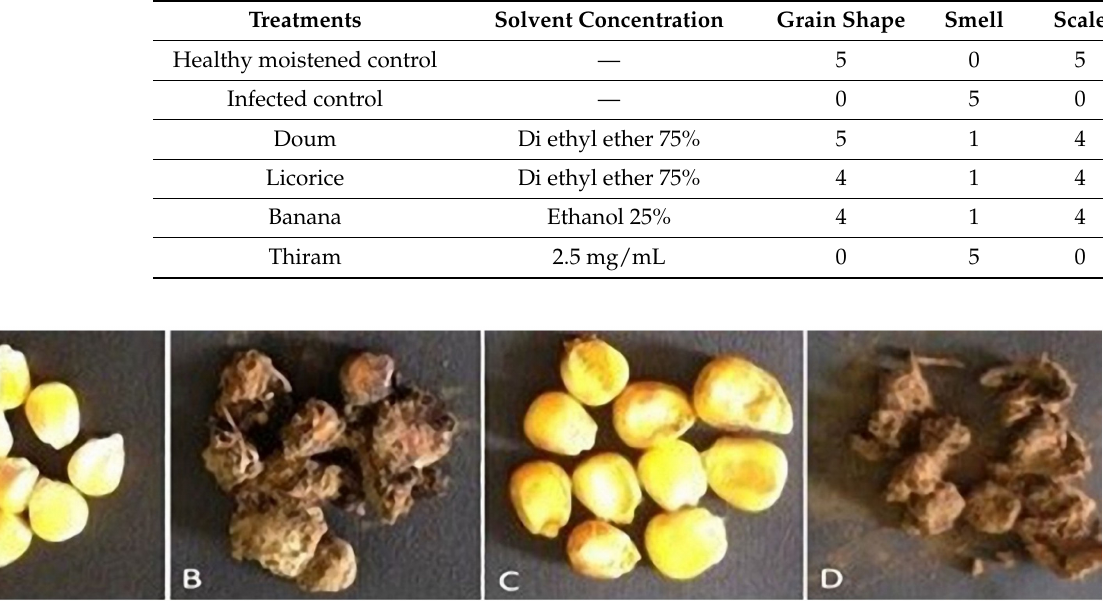
Figure 1. Effects of the plant extracts and Thiram fungicide on the appearance of inoculated maize grains after one month of storage: ( A ) healthy moistened control, ( B ) infected control inoculated with A. flavus , ( C ) inoculated maize grains treated with any of the tested extracts, ( D ) inoculated maize grains treated with Thiram